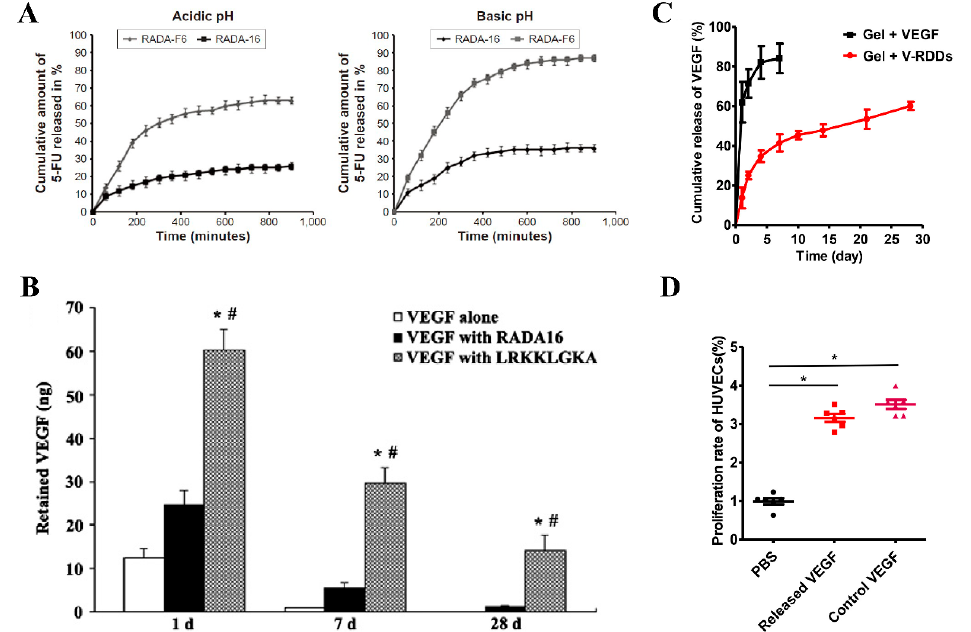
Figure 7. Modification of RADA16-Ifor drug delivery. ( A ) In-vitro 5-FU release profile from RADA-F6 and RADA-16 at two different pH, namely, acidic (pH 2) and basic (pH 7.8). Adapted with permission from Ref. [95]. Copyright 2016 International journal of nanomedicine. ( B ) Sustained release of VEGF by RAD/LRK (LRKKLGKA) over 28 days. * p < 0.01 versus the RADA16 group. # p < 0.01 versus the VEGF group. Adapted with permission from Ref. [99]. Copyright 2012 Biochemical and biophysical research communications. ( C ) Release profiles of VEGF from the RADA16 hydrogel alone ( ■ ) or the V-RDDs-anchoring-hydrogel ( ● ) over 28 days ( n = 3); ( D ) Bioactivity of VEGF released from the V-RDDs-anchoring hydrogel comparing with those of PBS (negative control) or free VEGF (positive control), ( n = 6, * p < 0.05). Adapted with permission from Ref. [97]. Copyright 2017 Journal of Controlled Release. Table 2. List of the source, application fields, and partial activity of modified RADA16-1 active motifs.